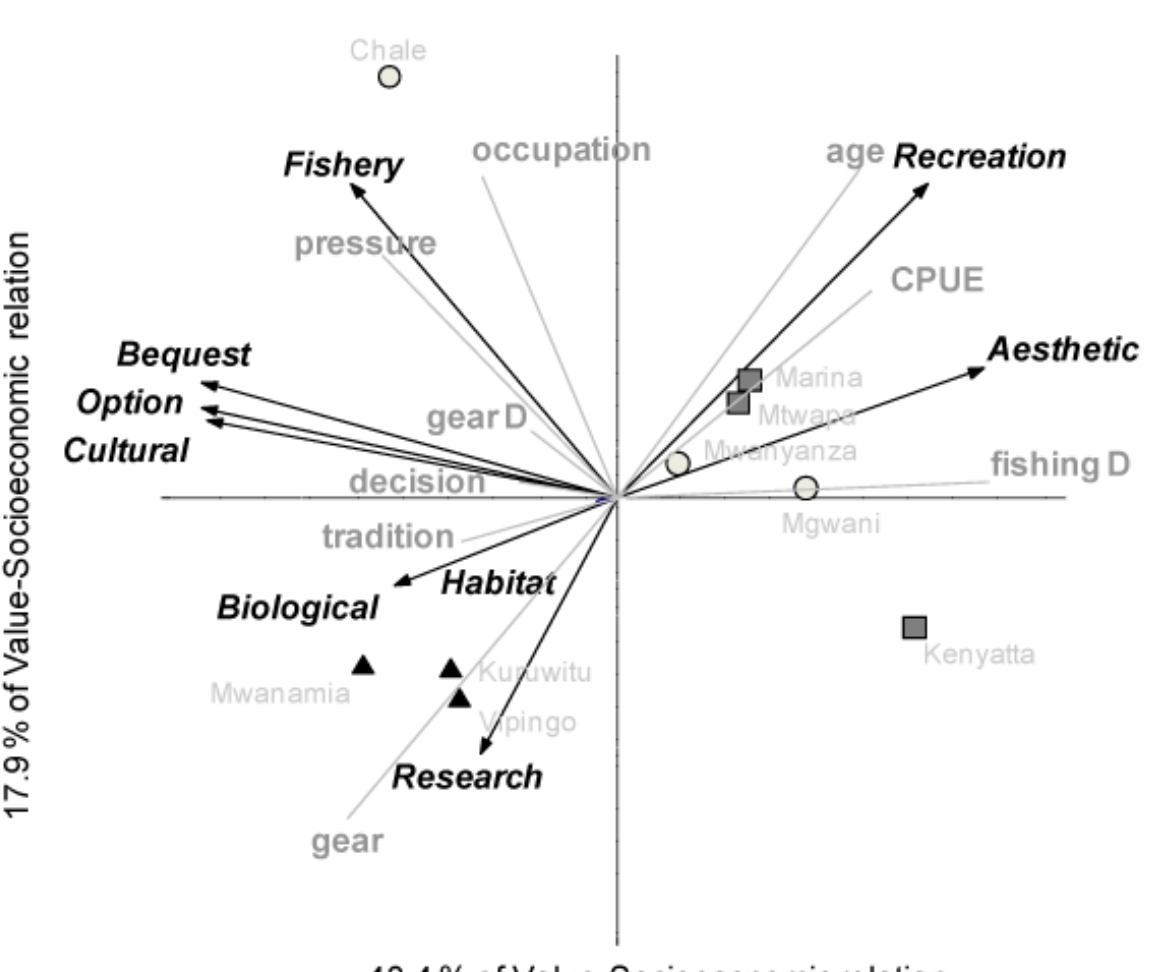
Fig. 3. Redundancy analysis (linear, direct gradient analysis) of the sites as driven by the economic valuation of the macro and community-level goods and services, with social variables overlain as eigenvectors. Economic values and socioeconomic variables were square-root transformed, and the ordination was value centered and standardized. The X- axis represents 48.4% and the y-axis 17.9% of the economic value–social variable variation. Community (black triangle), Government (dark-gray square), Co- (light-gray circle) economic values (black arrow), socioeconomic variable (gray